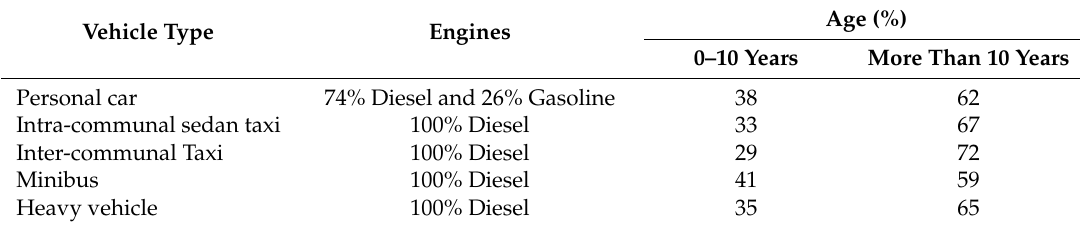
Table 3. Repartition of the vehicle fleet and percentage by motorization type and